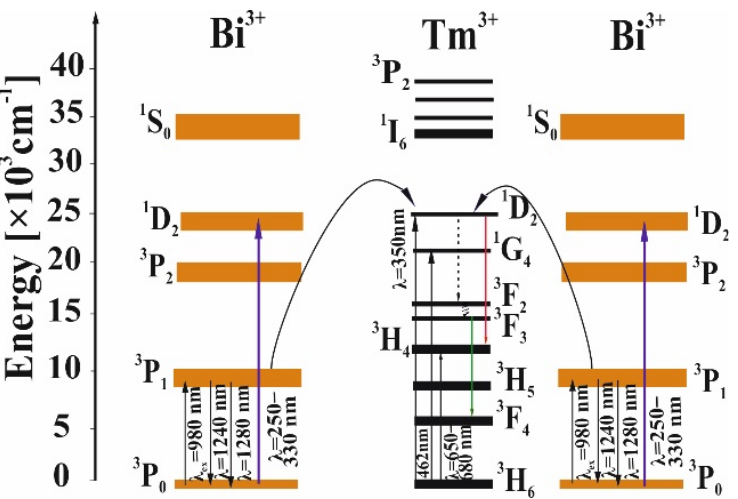
Figure 5. Energy diagram of Tm 3+ and Bi 3+ ions with experimentally observed transitions in the visible and infrared regions at T = 80 K.